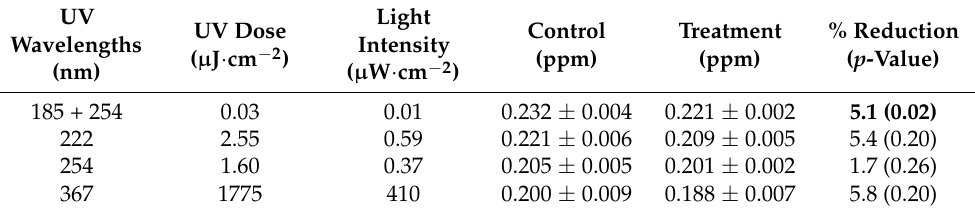
Table 7. Mitigation of N 2 O with different UV wavelengths irradiating gaseous emissions